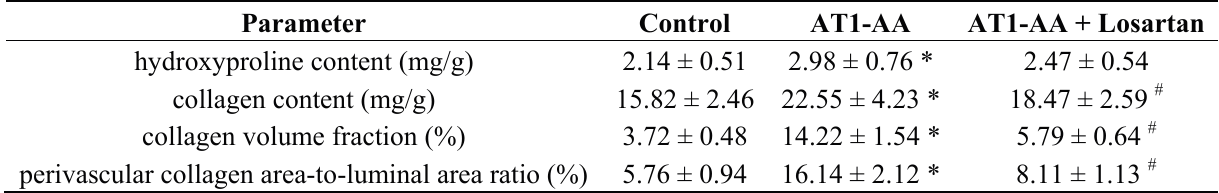
Table 3. Effects of AT1-AA on interstitial collagen volume fraction and peri-vascular collagen area-to-luminal area ratio of the